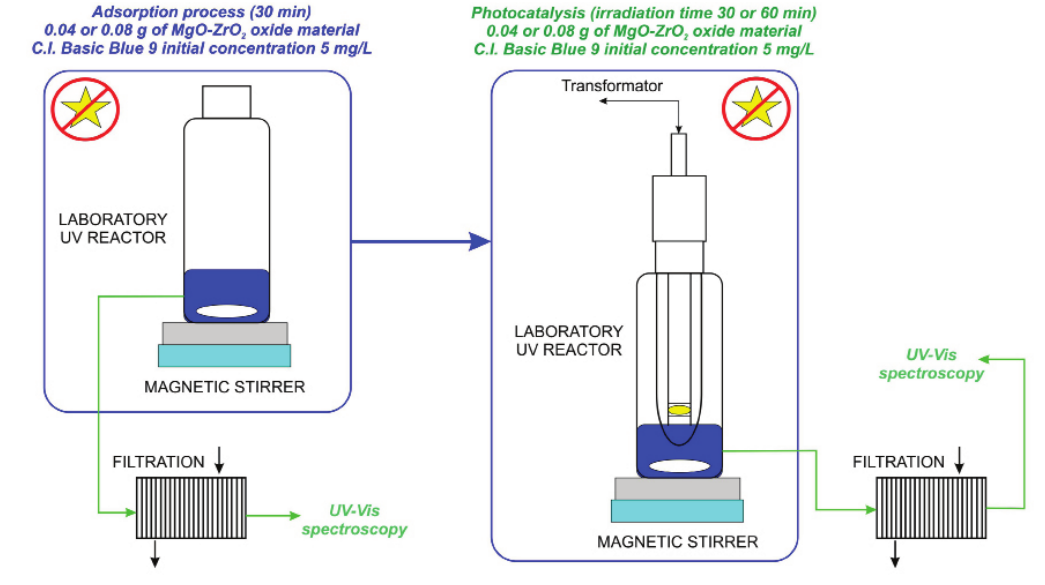
Figure 3: Adsorption and photocatalysis of C.I. Basic Blue 9 dye using synthesized MgO-ZrO